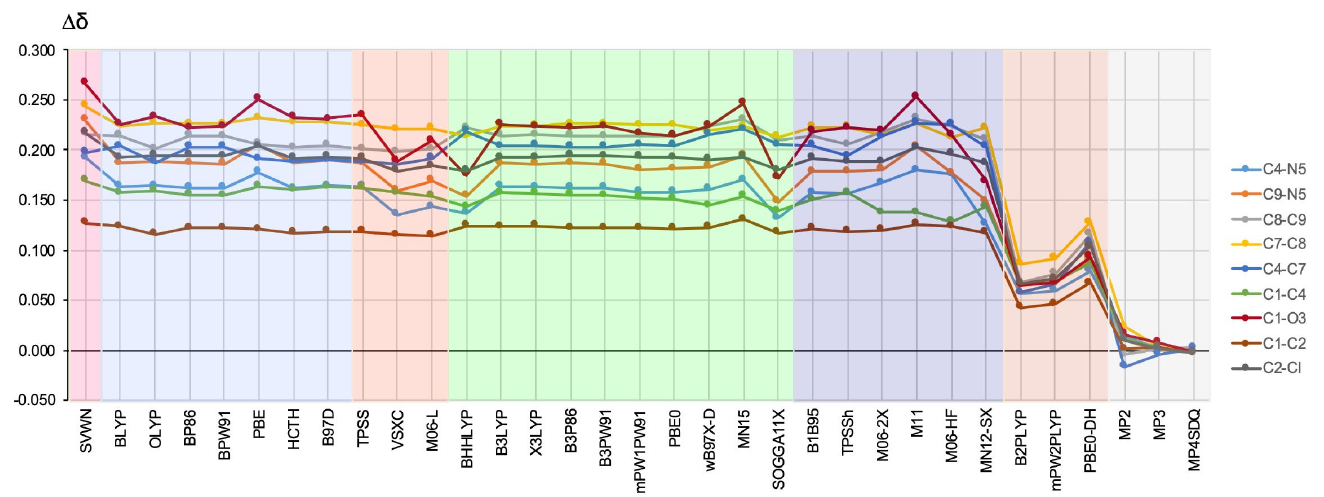
Figure 8. The difference (in relation to the CCSD method) in the value (in a.u.) of the delocalization index for the bonds shown on the right side of the figure. The different types of methods are represented by a colored background: LDA—pink, GGA—blue, M-GGA—orangeish, H-GGA—green, HM-GGA—violet, DH-GGA—beige, perturbational